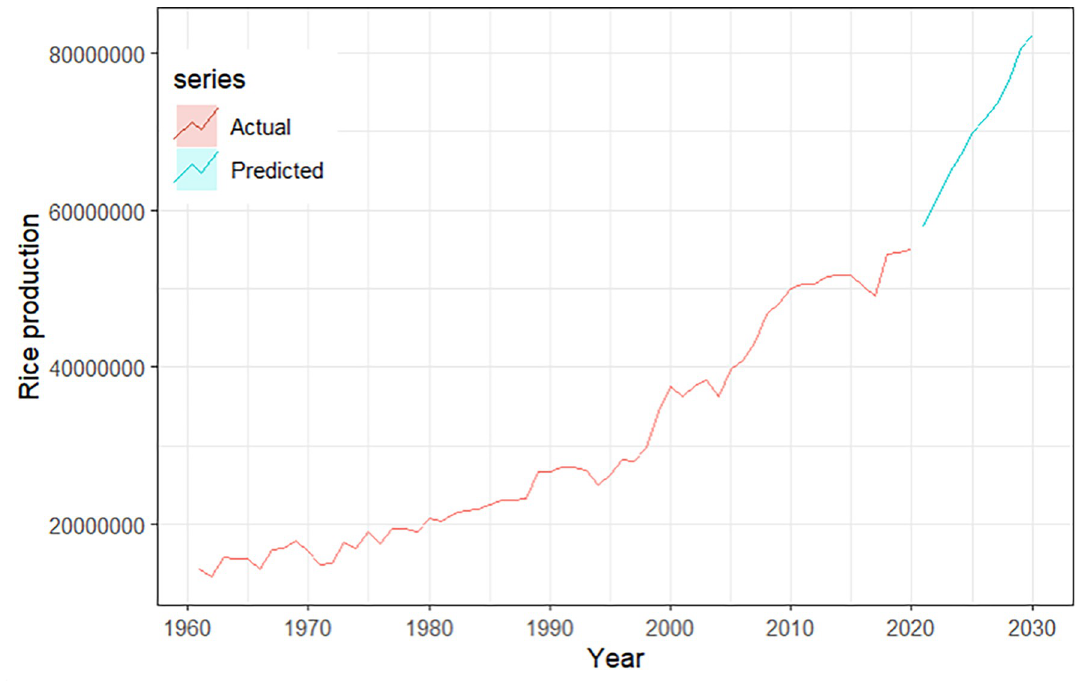
Fig 10. Ten years’ prediction of annual rice production in Bangladesh using XGBoost model. XGBoost: eXtreme Gradient Boosting.